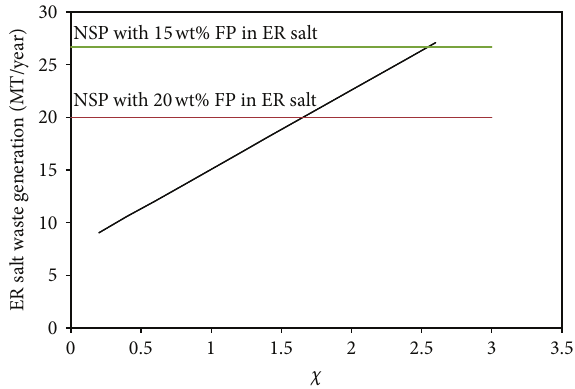
Figure 4: Comparison of ER salt waste generation rates for a 100MT/year facility using selective process (black curve) versus nonselective process (NSP) with two different levels of fission product accumulation in the electrorefiner for used metal fuel processing.